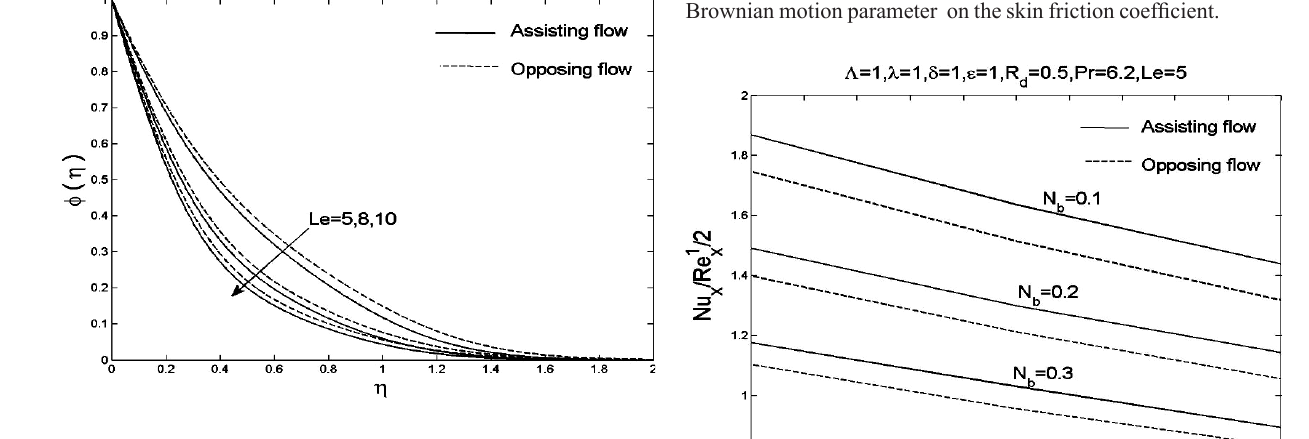
Fig. 26. The effect of the lewis number Le on the concentration profiles ( ) φη .